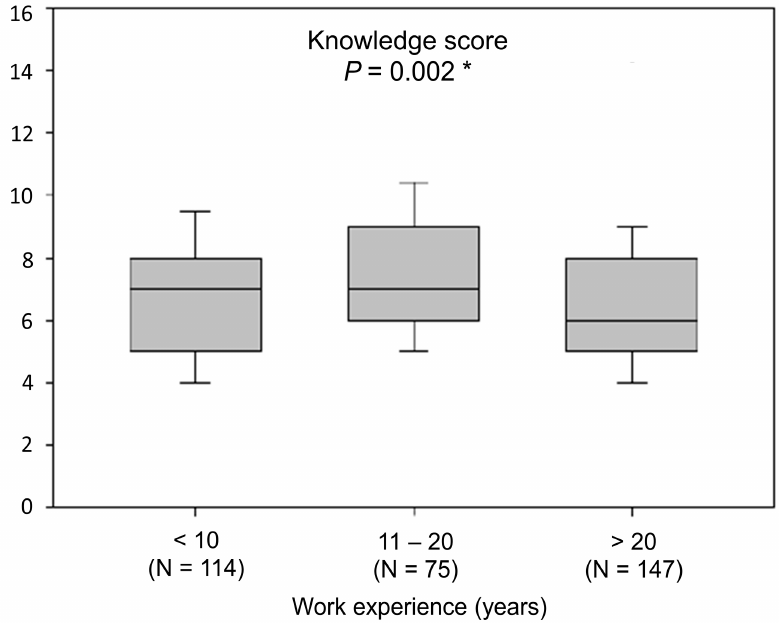
Figure 1. Knowledge score relative to work experience. * Kruskal–Wallis with post-hoc Conover test. Data are presented as median (interquartile range).